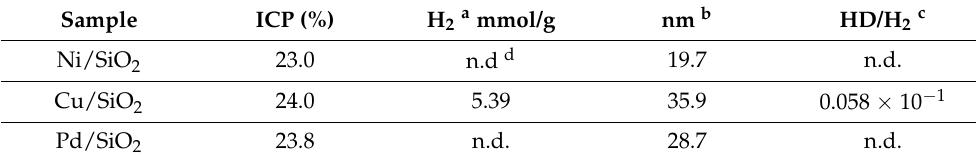
Table 1. Physico-chemical properties of monometallic